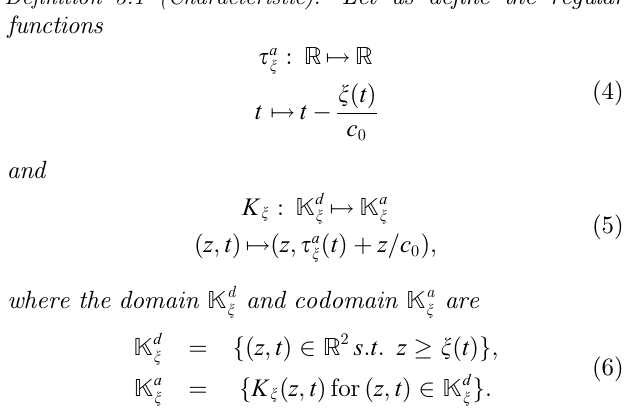
Figure 3. Illustration of the mapping from departure coordi- nates ð n ð t d Þ ; t d Þ to arrival coordinates ð Z ; t a Þ through the characteristic line (described by K n ð z ; t d Þ when z varies), for a sinusoidal piston motion. Note the variation in the propagation time t a (cid:2) t d ¼ Z (cid:2) n ð t d Þ c 0